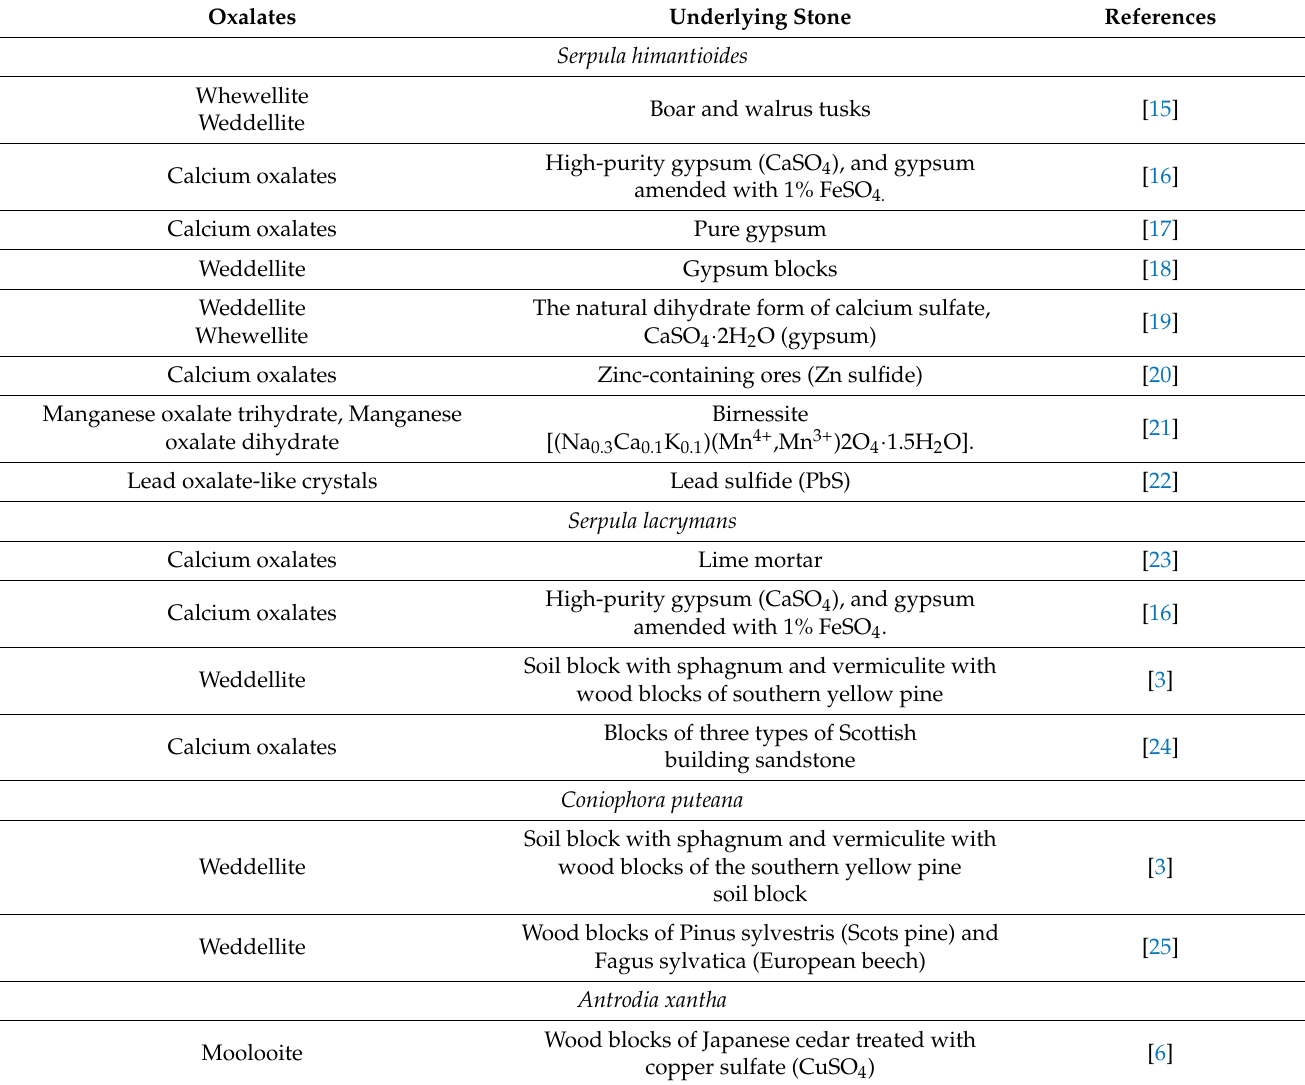
Table 1. Metal oxalates obtained in vitro under the action of brown rot